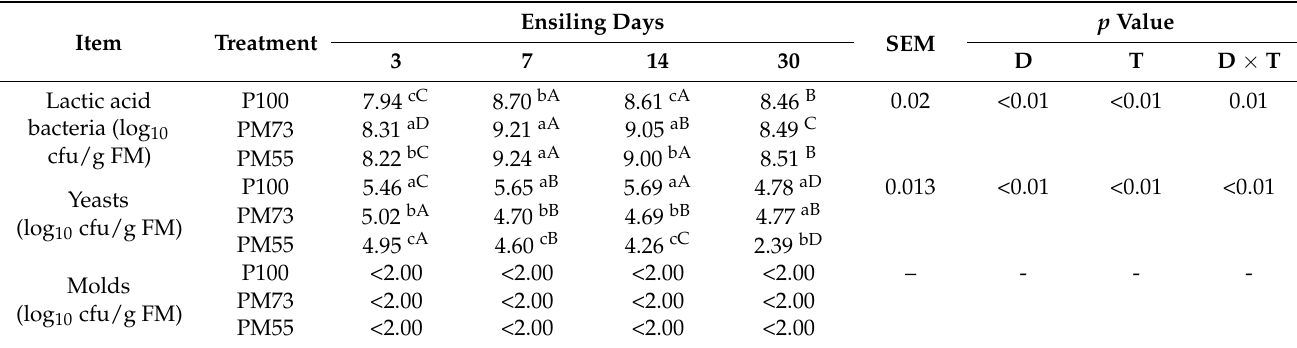
Table 5. The microbial population of mulberry leaves and hybrid Pennisetum .